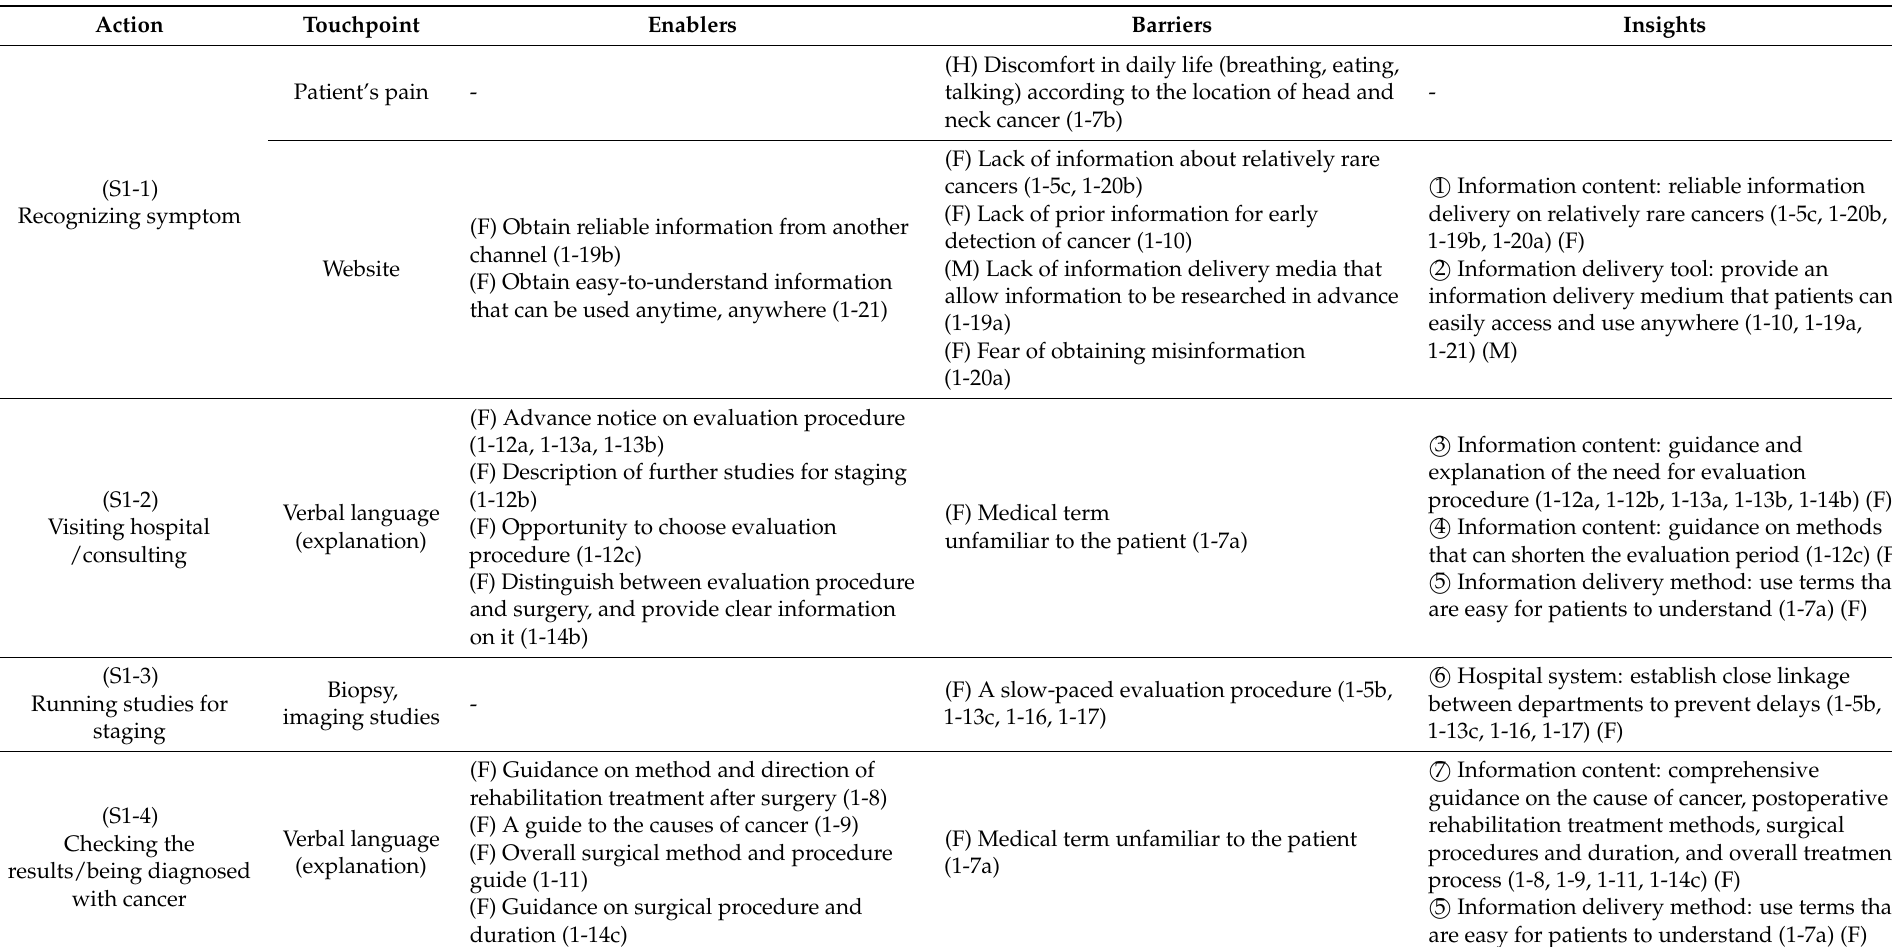
Table A1. (1) Journey Stage 1: studies for cancer diagnosis and staging. (2) Journey Stage 2: pre-operative counseling. (3) Journey Stage 3: getting operation consent. (4) Journey Stage 4: surgery and recovery. (5) Journey Stage 5: Rehabilitation and